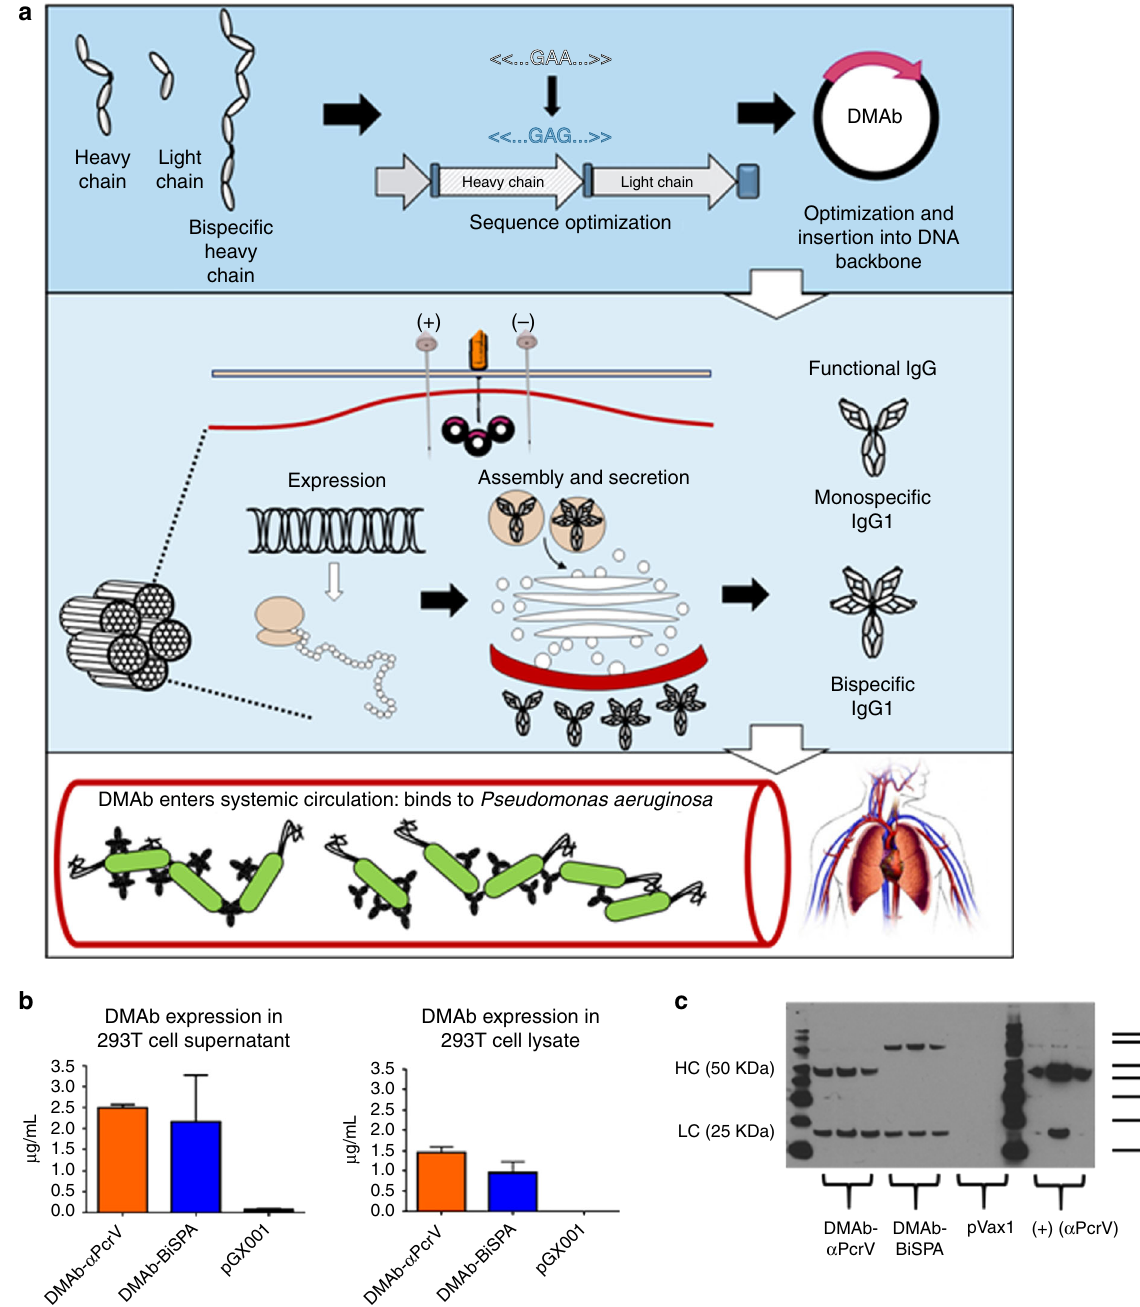
Fig. 1 Schematic diagram of DMAb delivery and in vitro expression. a DMAbs were designed to encode IgG antibody heavy and light chains of monoclonal antibody clones V2L2MD and MEDI3902, resulting in the DMAb- α PcrV and DMAb-BiSPA constructs. The optimized DMAb constructs are administered to mice by in vivo IM-EP, and muscle cells being to synthesize an produce mAb. Fully functional DMAb is secreted and enters the systemic circulation. (The image of the human circulatory system is licensed under a Creative Commons Share-Alike 3.0 License (CC-BY-SA) https://creativecommons.org/ licenses/by-sa/3.0/ and can be found at thecardiovascularsystem.wikispaces.com/HOME). b HEK 293 T cells were transfected with 1 µ g/well of DMAb- α PcrV, DMAb-BiSPA, or control pGX0001. Supernatant and cell lysates were harvested after 48 h. Samples were assayed for human IgG. Error bars represent the standard deviation. c A Western blot was performed with cell lysates from transfected cells. 10 µ g total cell lysate was loaded in each lane and run on an SDS-PAGE gel, followed by transfer onto a nitrocellulose membrane. The membrane was probed with a goat anti-human IgG H + L antibody, conjugated to HRP. Samples were developed using an ECL chemiluminescence kit and visualized on fi intramuscular (IM) injection in the tibialis anterior (TA), fol- con fi rmation of expression in vivo, we performed further lowed by intramuscular electroporation (IM-EP). Muscle tissue experiments to assay DMAb levels in systemic circulation. was harvested 3 days post injection and sections were probed with Human IgG1 induces an anti-antibody response in immuno- a goat anti-human IgG Fc antibody followed by detection with a competent mice, since it is recognized as non-self by the murine donkey anti-goat IgG conjugated to AF488 (Fig. 2). Following immune system. Therefore, we fi rst evaluated expression in